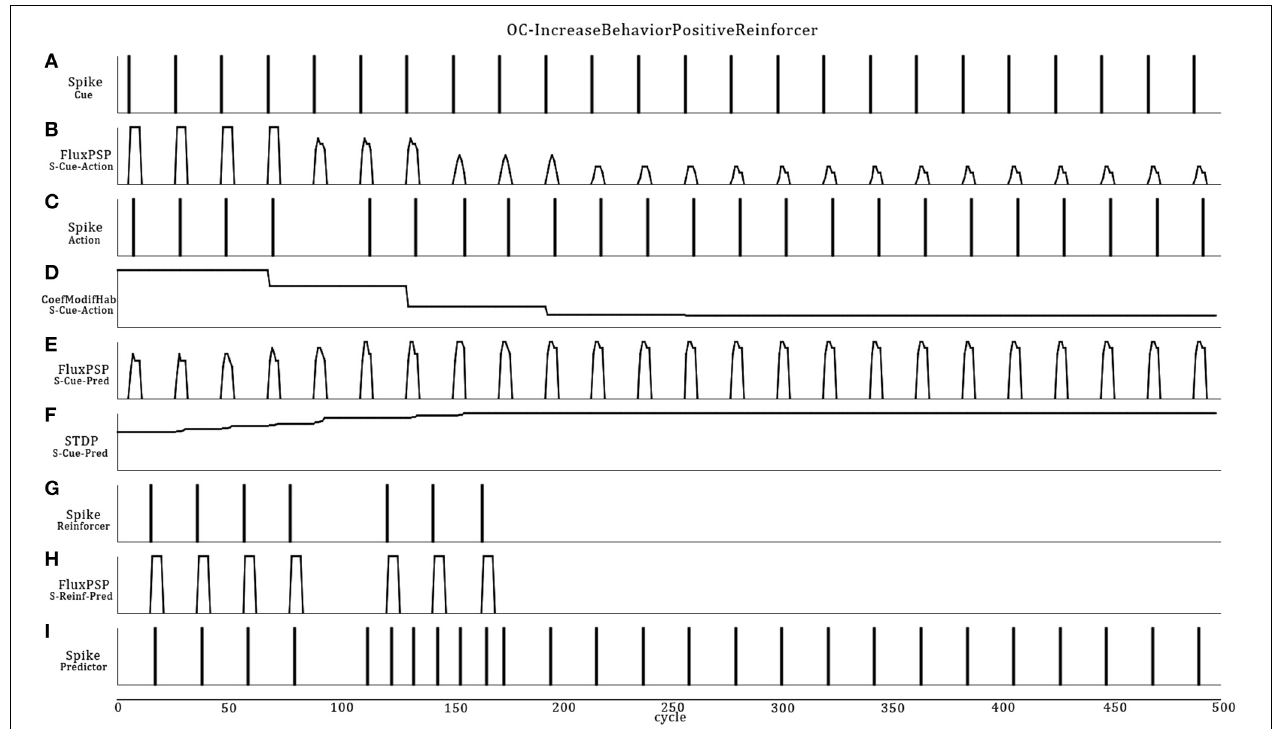
FIGURE 5 | Dynamic ASNN states (Figure 4) involved in an OC procedure. The Cue neuron (A) emits spikes in reaction to regular vibes pacing into the virtual world. The strong synaptic link between Cue and Action first commands the robot to do actions (C) implemented as sound emissions. Because the synapse between Cue and Action incorporates a habituation rule which decrease the synaptic efficiency (D) , the PSP eventually fades enough to stop the action around cycle 100 (B) . Simultaneously, Cue emits spikes toward the Predictor neuron, causing small